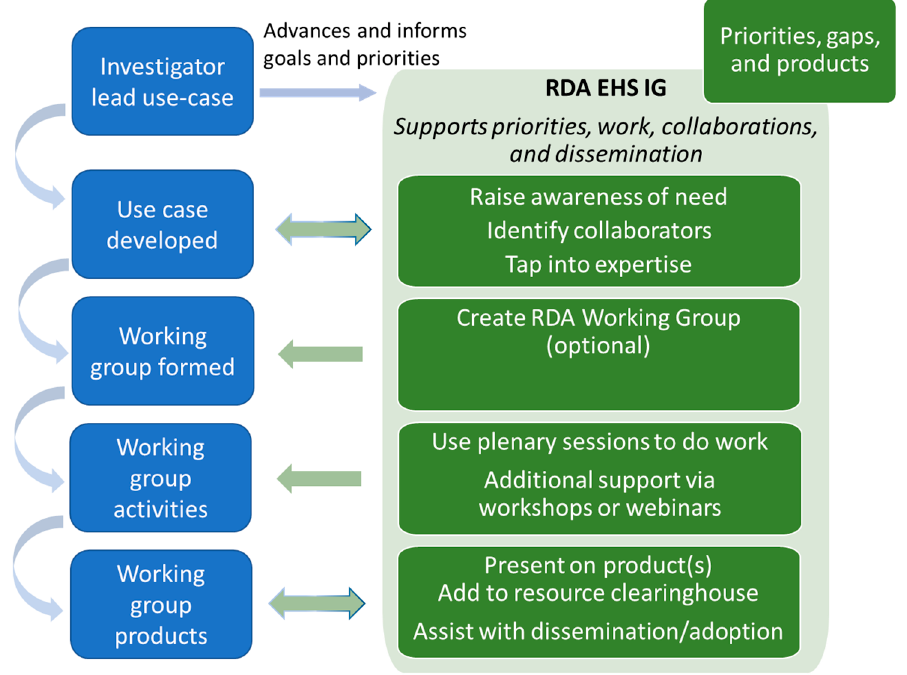
Figure 3. The community model in